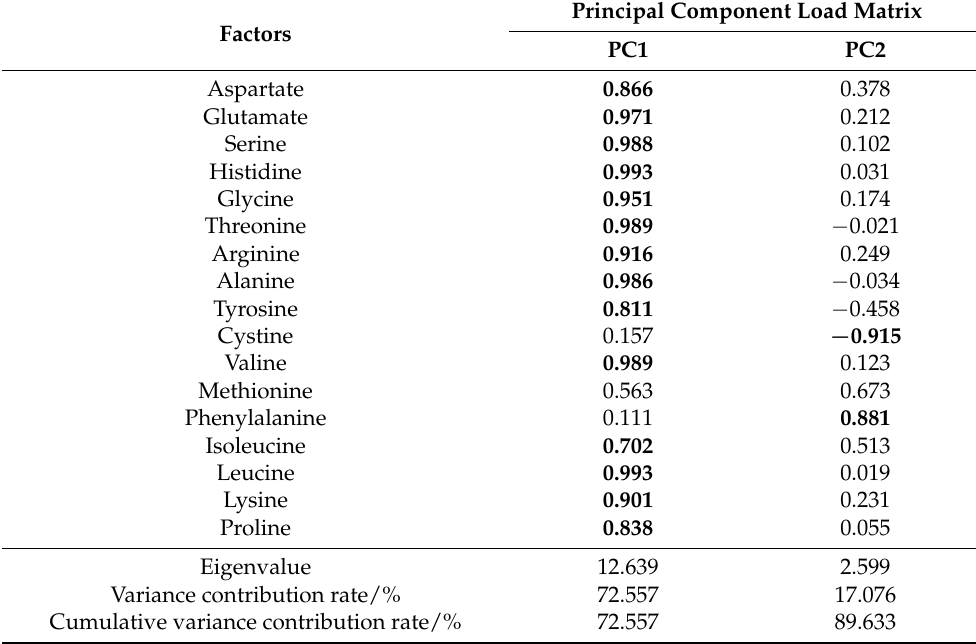
Table 6. Principal component load matrix and